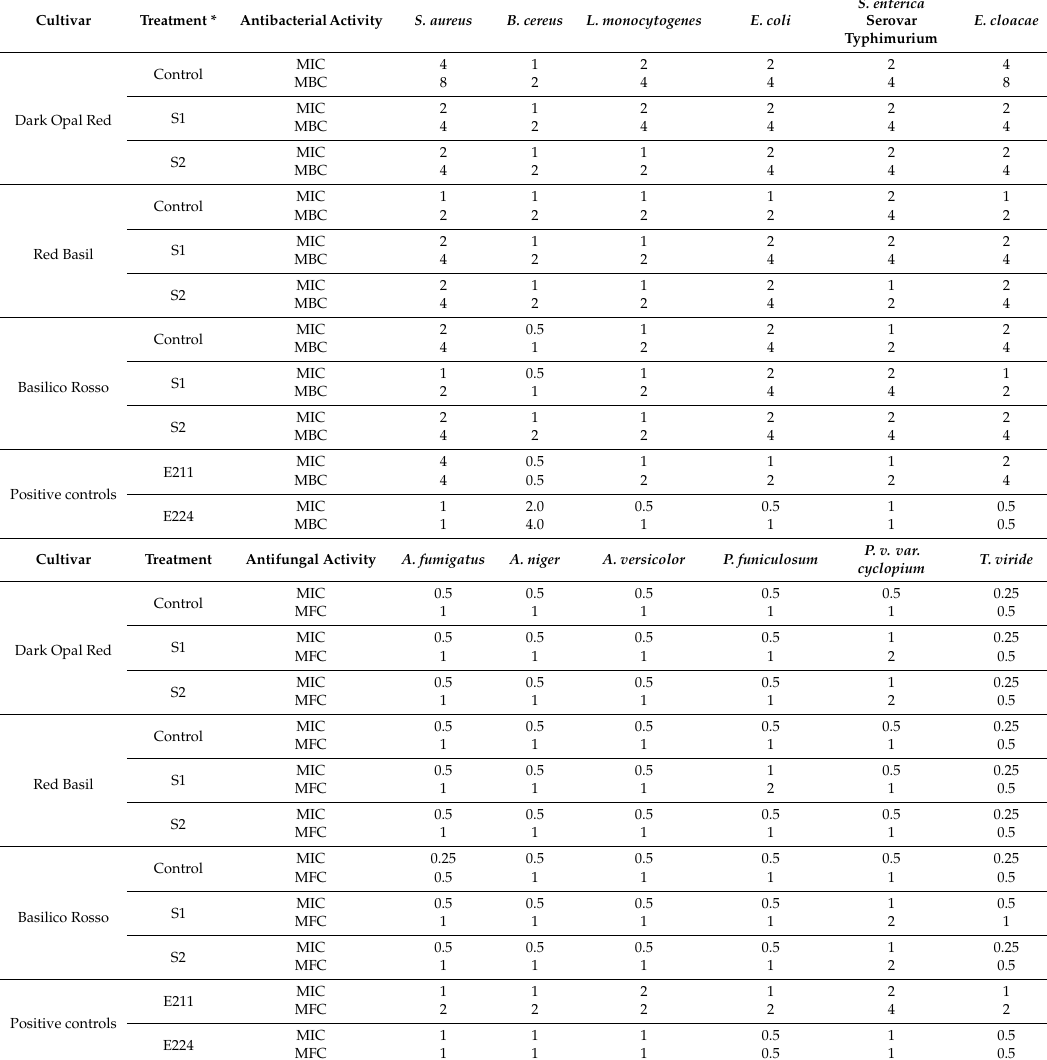
Table 6. Antibacterial and antifungal activity (mg / mL) of hydroethanolic extracts of the leaves of the tested basil cultivars in relation to salinity